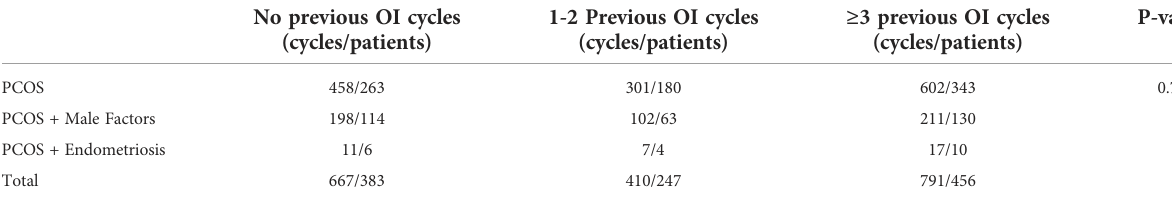
TABLE 1 Indications of PCOS patients undergoing IUI.